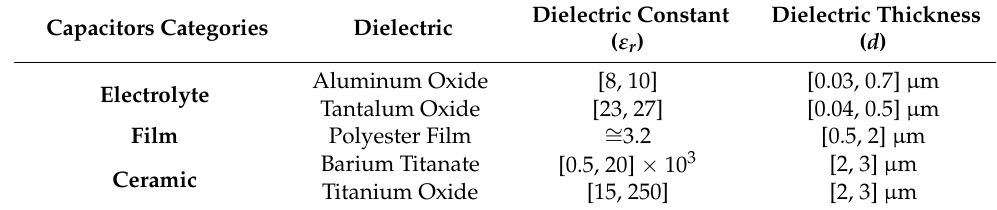
Table 1. Dielectric constants and the minimal thickness for several sorts of capacitors [1–3]. Capacitors